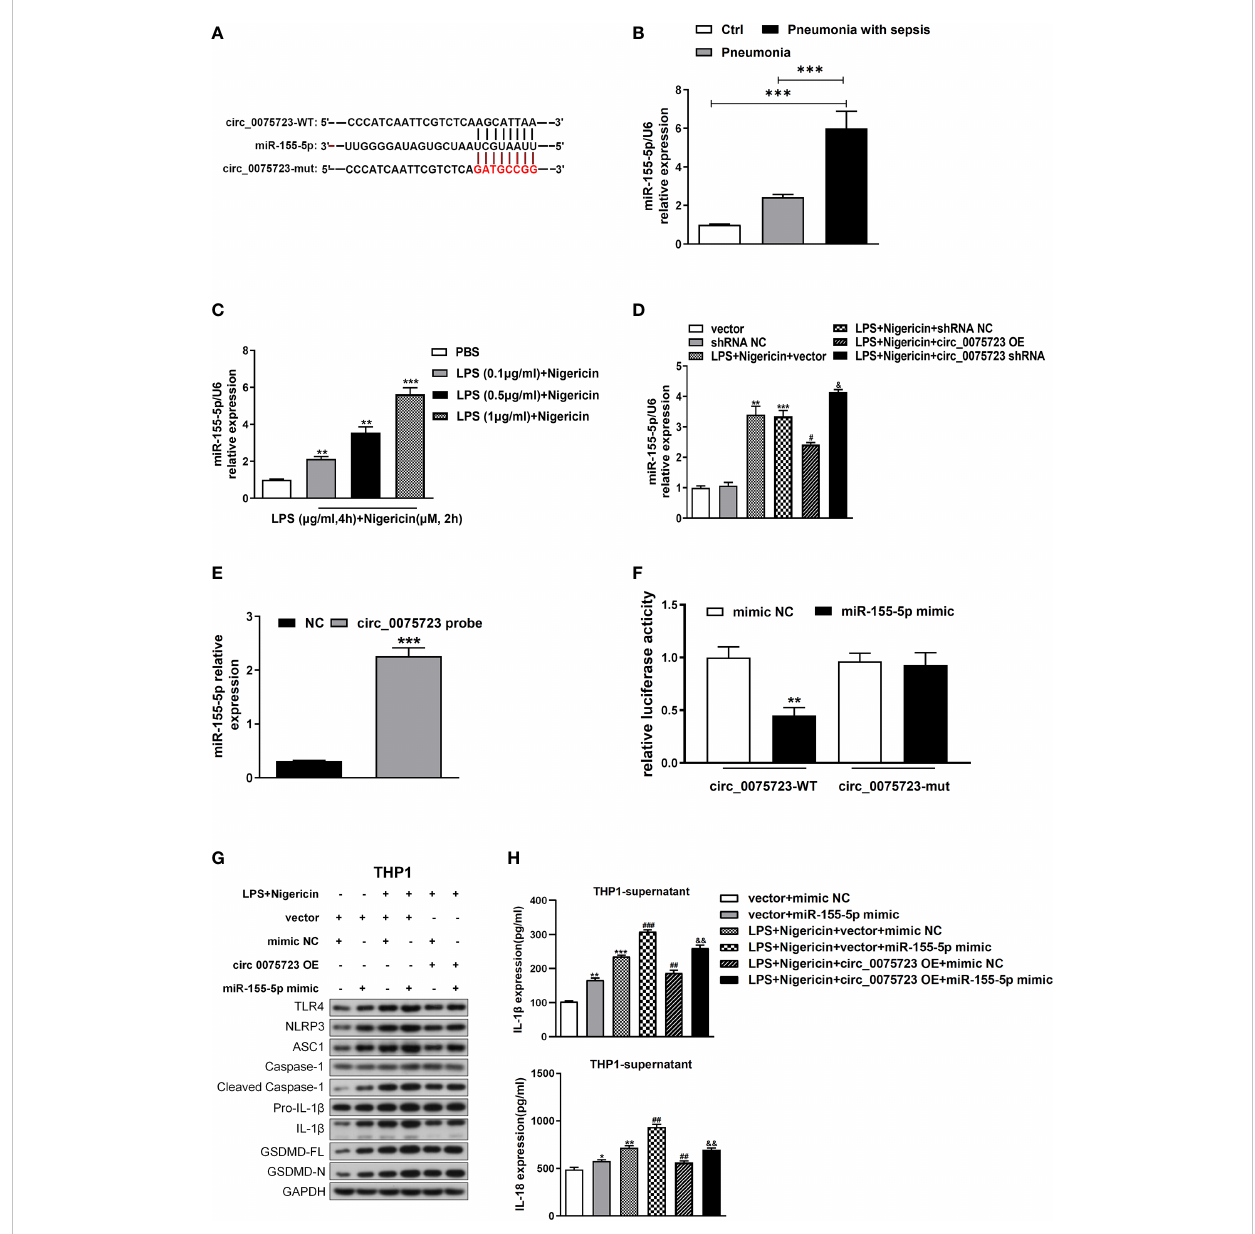
FIGURE 4 Circ_0075723 functions as a sponge for miR-155-5p in THP-1. (A) Schematic showing the predicted miR-155-5p sites in circ_0075723. (B) qRT-PCR analysis of the expression of miR-155-5p in CD14+ monocytes among the pneumonia-induced sepsis, pneumonia without sepsis and healthy control group. Each group has 4 samples. Data are presented as means ± SD; signi fi cant difference was identi fi ed with one-way ANOVA; ***P < 0.001 vs. Control or Pneumonia. (C) qRT-PCR analysis of the expression of miR-155-5p in THP-1 cells primed with different doses of LPS (0.1, 0.5 and 1 m g/ml) for 4 h and stimulated with nigericin (10 m M) for 2h. Data are presented as means ± SD; signi fi cant difference was identi fi ed with Student t -tests. **p < 0.01 vs. PBS; ***p < 0.001 vs. PBS. (D) THP-1 cells were transfected with vector or shRNA scrambled control (shRNA NC) or were transfected with circ_0075723-overexpressing lentivirus plasmids (OE-circ_0075723), sh-circ_0075723-expressing lentivirus plasmids (sh-circ_0075723), vector or shRNA scrambled control (shRNA NC) and then were primed with LPS (1 m g/ml) for 4 h and stimulated with nigericin (10 m M) for 2h. qRT-PCR analysis of the expression of miR-155-5p in THP-1 cells. Data are presented as means ± SD; signi fi cant difference was identi fi ed with Student t -tests. **p < 0.01 vs. vector; ***p < 0.001 vs. shRNA NC; #p < 0.05 vs. LPS/nigericin + Vector; &p < 0.05 vs. LPS/nigericin + shRNA NC. (E) RNA pull-down analysis of the interaction between miR-155-5p and circ_0075723. Data are presented as means ± SD; signi fi cant difference was identi fi ed with Student t -tests. ***p < 0.001 vs. NC group. (F) Dual-luciferase reporter assay was performed to validate the association between miR-155-5p and circ_0075723. Data are presented as means ± SD; signi fi cant difference was identi fi ed with one-way ANOVA. **p < 0.01 vs. mimic NC group. THP-1 cells were transfected with vector + mimic scrambled control (mimic NC) or vector + miR-155-5p mimic or were transfected with vector + mimic NC, vector + miR-155-5p mimic, mimic NC + circ_0075723 lentivirus plasmids (circ_0075723 OE), or miR-155-5p mimic + circ_0075723 OE and then were primed with LPS (1 m g/ml) for 4 h and stimulated with nigericin (10 m M) for 2h. (G) Western blot analysis of TLR4, NLRP3, ASC1, caspase1, cleaved caspase-1, Pro-IL1 b , IL-1 b , GSDMD and GAPDH in THP-1 cells. (H) ELISA of IL-18 and IL-1 b in THP-1 supernatant. Data are presented as means ± SD; signi fi cant difference was identi fi ed with Student t -tests. *p < 0.05 vs. vector + mimic NC; **p < 0.01 vs. vector + mimic NC; ***p < 0.001 vs. vector + mimic NC; ##p < 0.01 vs. LPS/nigericin + vector + mimic NC; ###p < 0.001 vs. LPS/nigericin + vector + mimic NC; &&p < 0.01 vs. LPS/nigericin + circ_0075723-OE + mimic